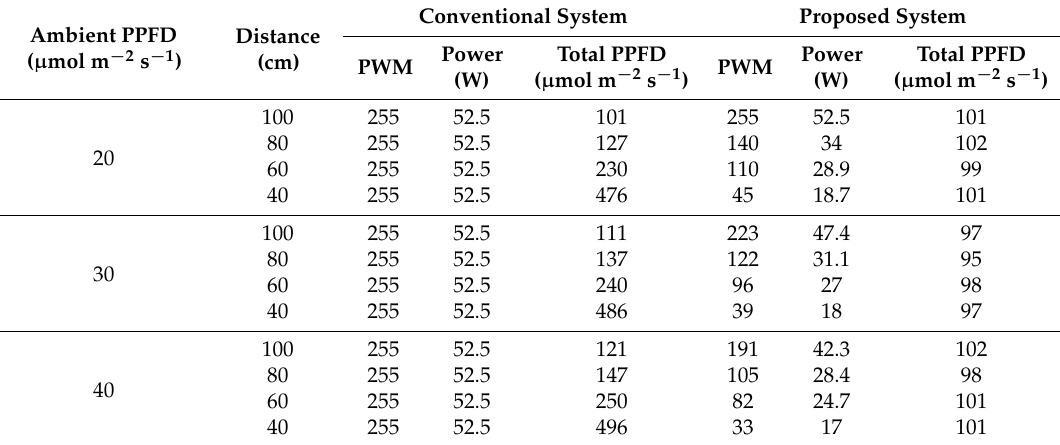
Table 4. pulse width modulation (PWM) signal and power consumption when the distance between a plant and the proposed LED system and ambient PPFD is changed.